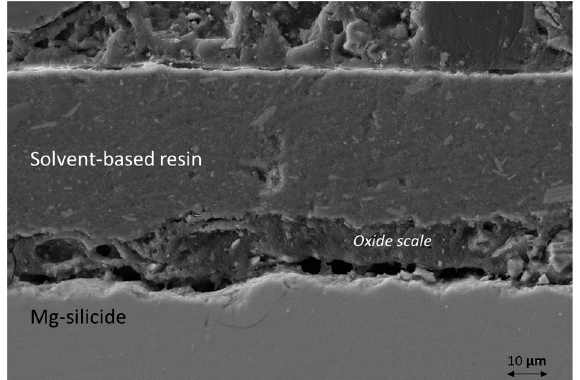
Figure 4. Cross sectional SEM image of solvent-based resin coated Mg-silicide after aging at 500 °C for 120 h, in air.